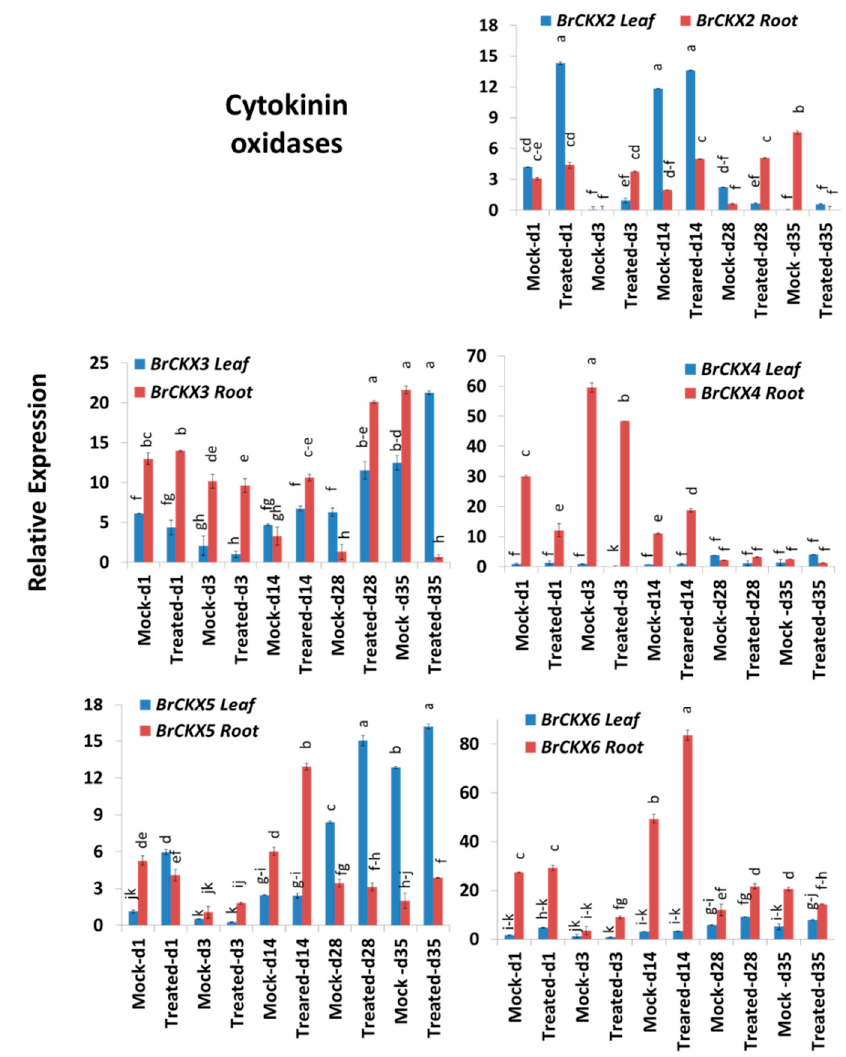
Figure 7. Variation in the relative expression levels of BrCKX cytokinin-related genes in leaf and root samples under different treatment × time-point combinations. Vertical bars compare relative expression levels among leaf vs. root, mock vs. treated samples at five time-points. Each data point represents the average of three samples. Vertical bars represent standard deviation. Values with different letters are significantly different at 5% level of significance according to Tukey’s pairwise comparisons. Gene expression levels in leaves from non-treated plants on Day 0 were set to 1.